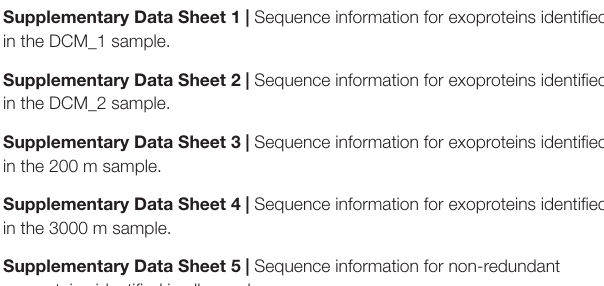
Supplementary Figure 1 | Scatter plot showing the abundance relationship between phage proteins and host exoproteins. Dots with different colors indicate different host